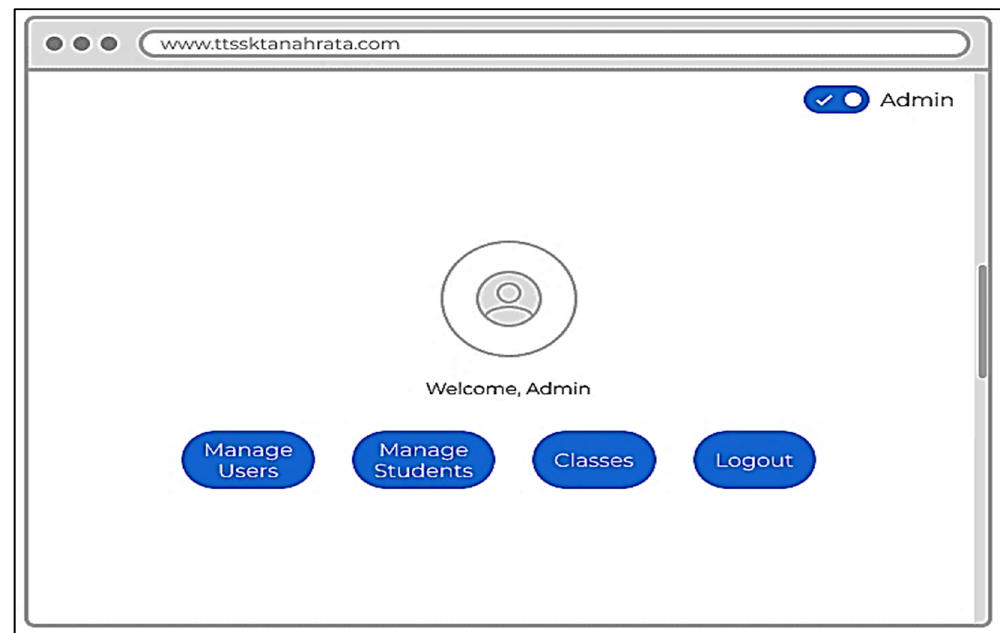
Figure 4. Landing Page Using Figma.